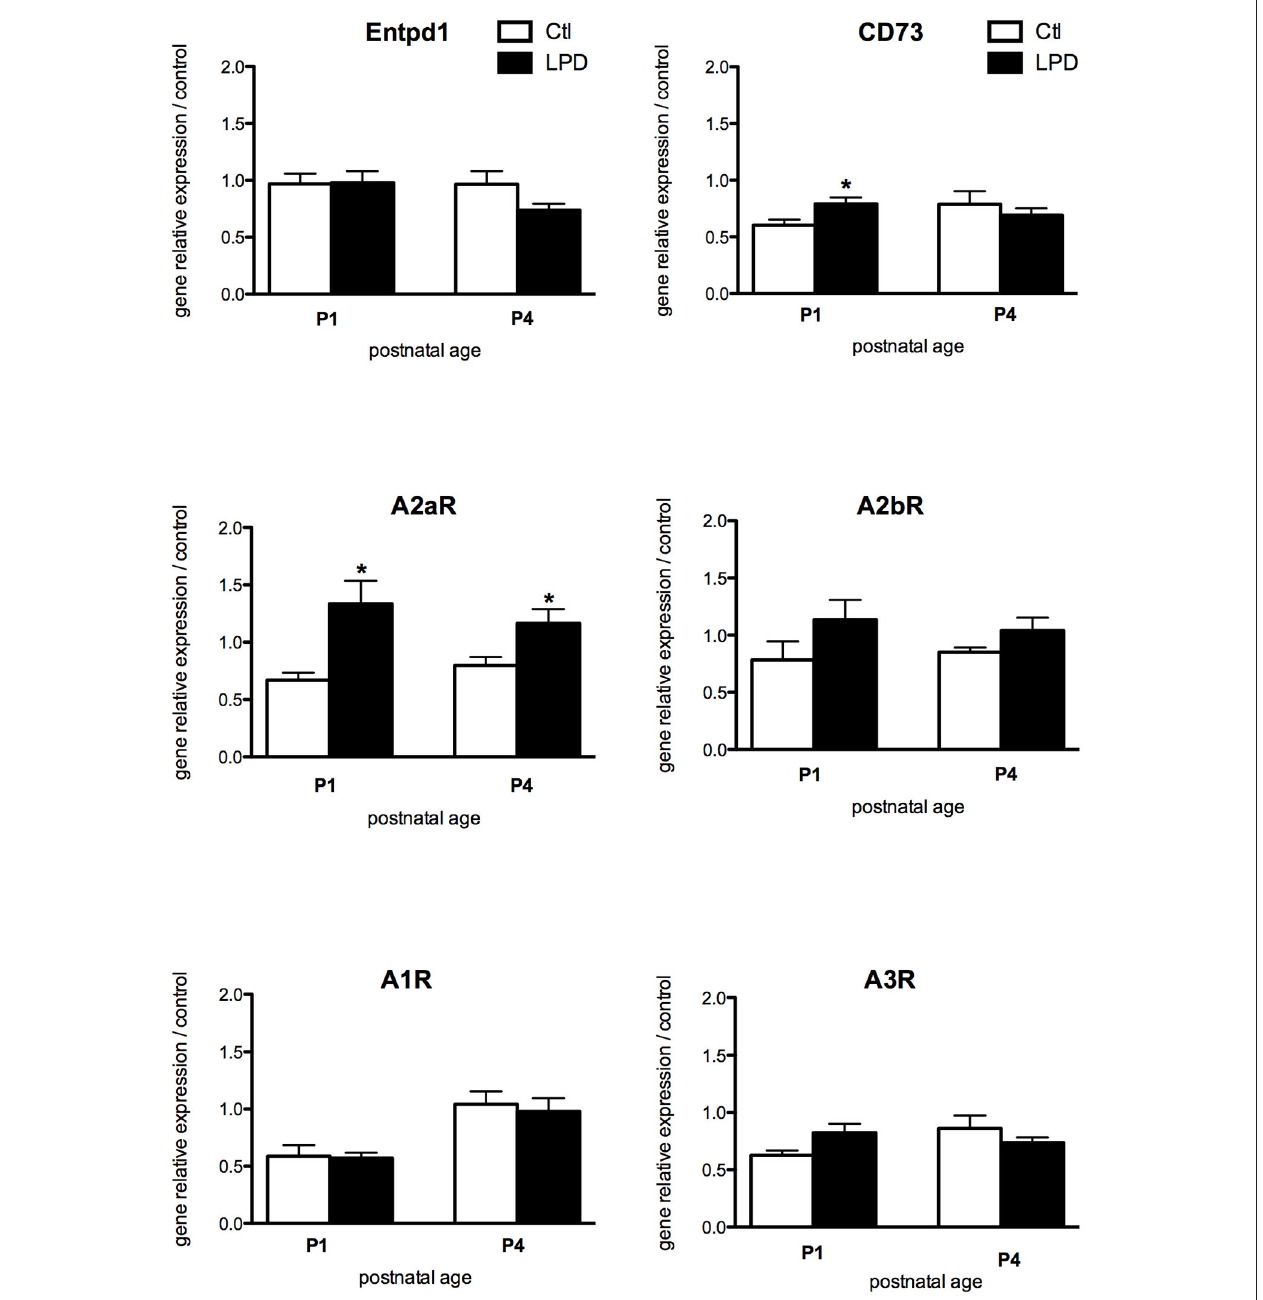
FIGURE 3 | Comparisons of gene expression of enzymes involved in the production of adenosine and its receptors in microglial cells sorted from animals exposed to LPD (black bars) and from control animals (white bars). Data are shown as relative expression of control values normalized to 1 (* p < 0.05, using unpaired Student’s t